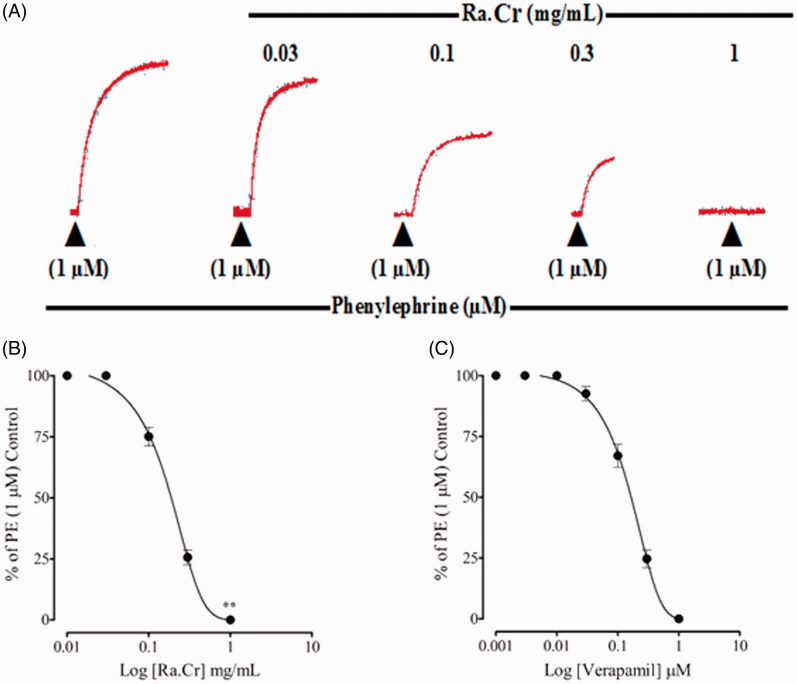
Typical tracing showing inhibitory effect of (A) increasing concentrations of the crude extract of Rumex acetosa (Ra.Cr) on the initial peak formation of phenylephrine (1 µM)-induced contractions in Ca2+-free medium. (B) The effect of Ra.Cr. (C) The effect of verapamil in isolated rabbit aorta preparations. Values shown are mean ± SEM. Five to six determinations.